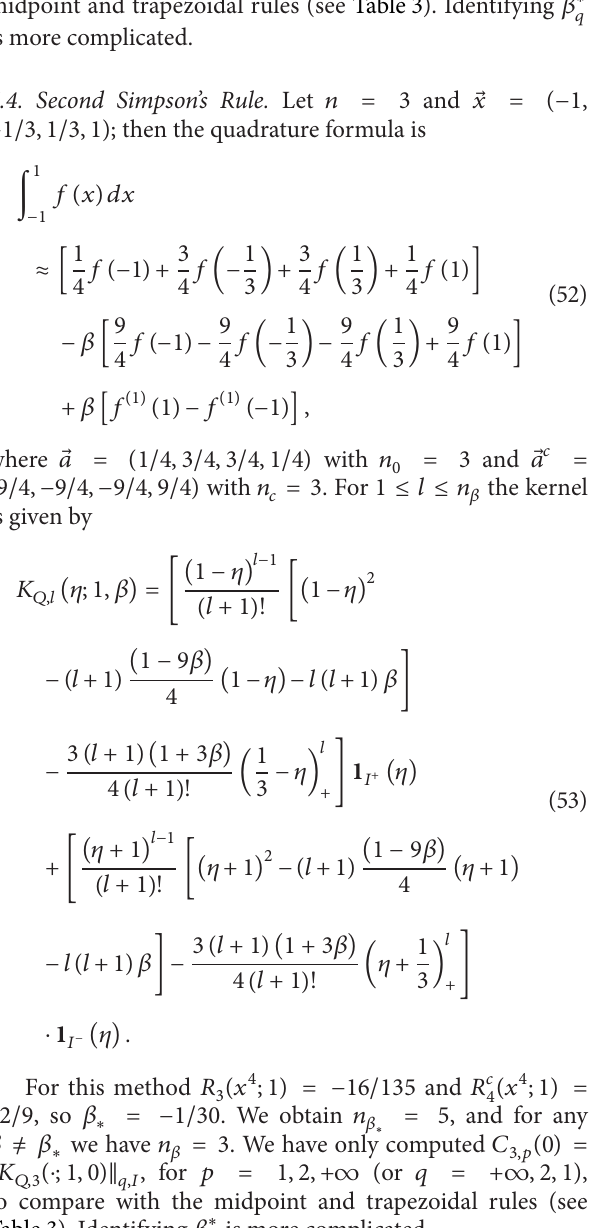
Table 2: Best constants for the trapezoidal rule.